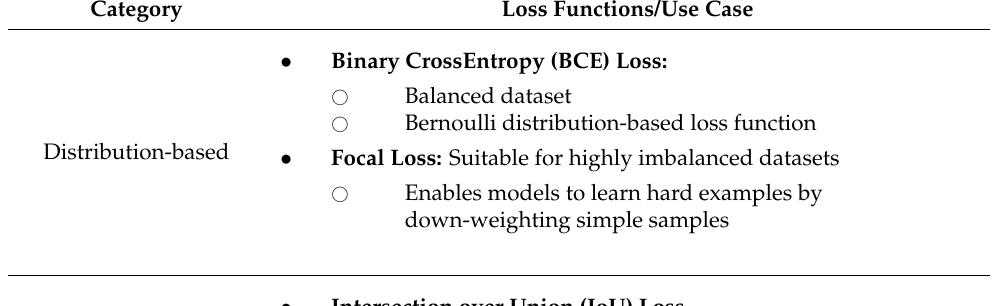
Table 1. The family and individual loss functions used in this